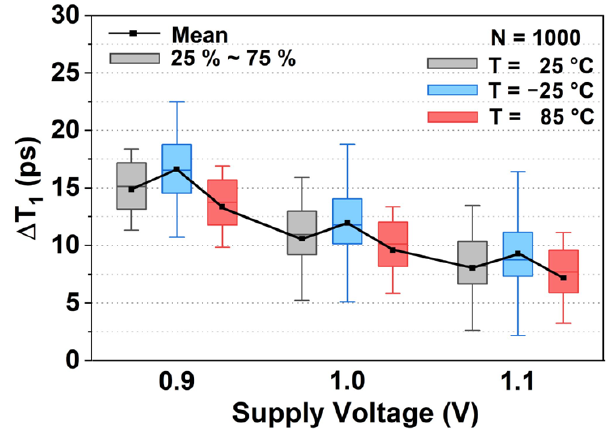
Figure 7. Mean and standard deviation of ∆ T 1 ( = t Logic1 + t DA,rst − t Latch ) under supply voltage and temperature variation.